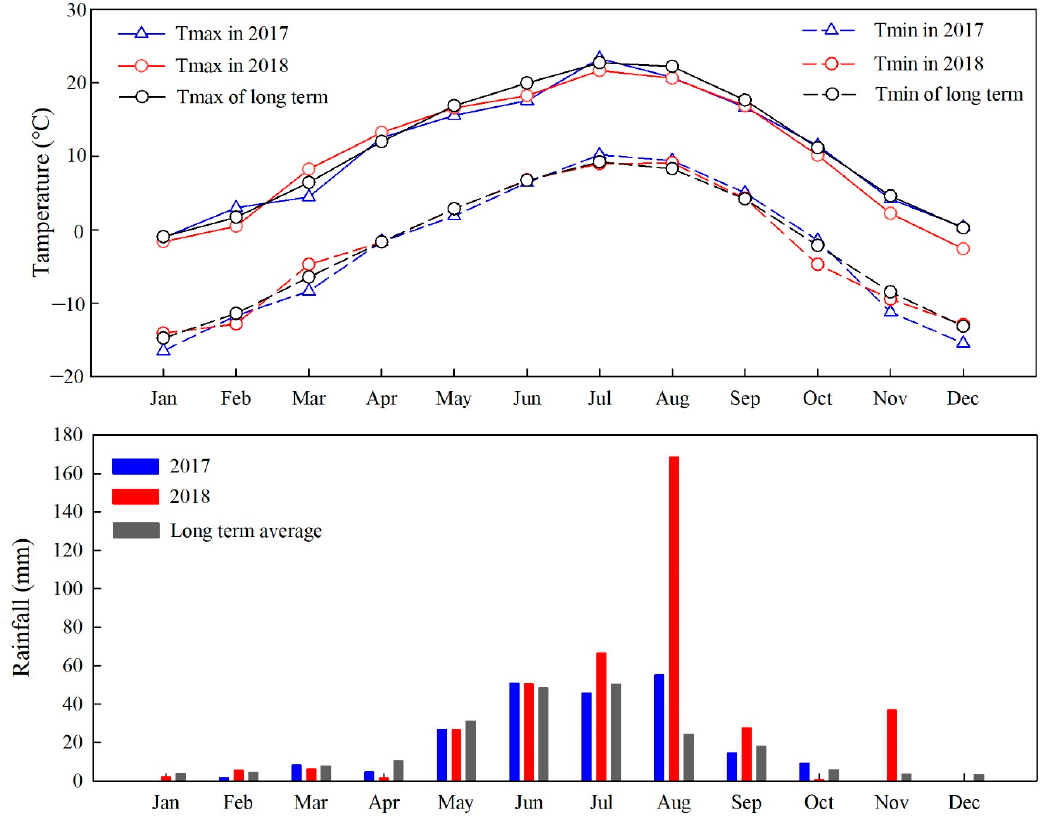
Figure 1. Monthly temperature and rainfall in 2017 and 2018 at the experiment site in Chaka. Soil at the site has distinct layers. The surface (0–40 cm) layer has a lower sand content with a high nutrient content and high water capacity. Soil texture in the surface layer and the layer below (40–100 cm) are silty loam and sandy loam, respectively. Soil organic